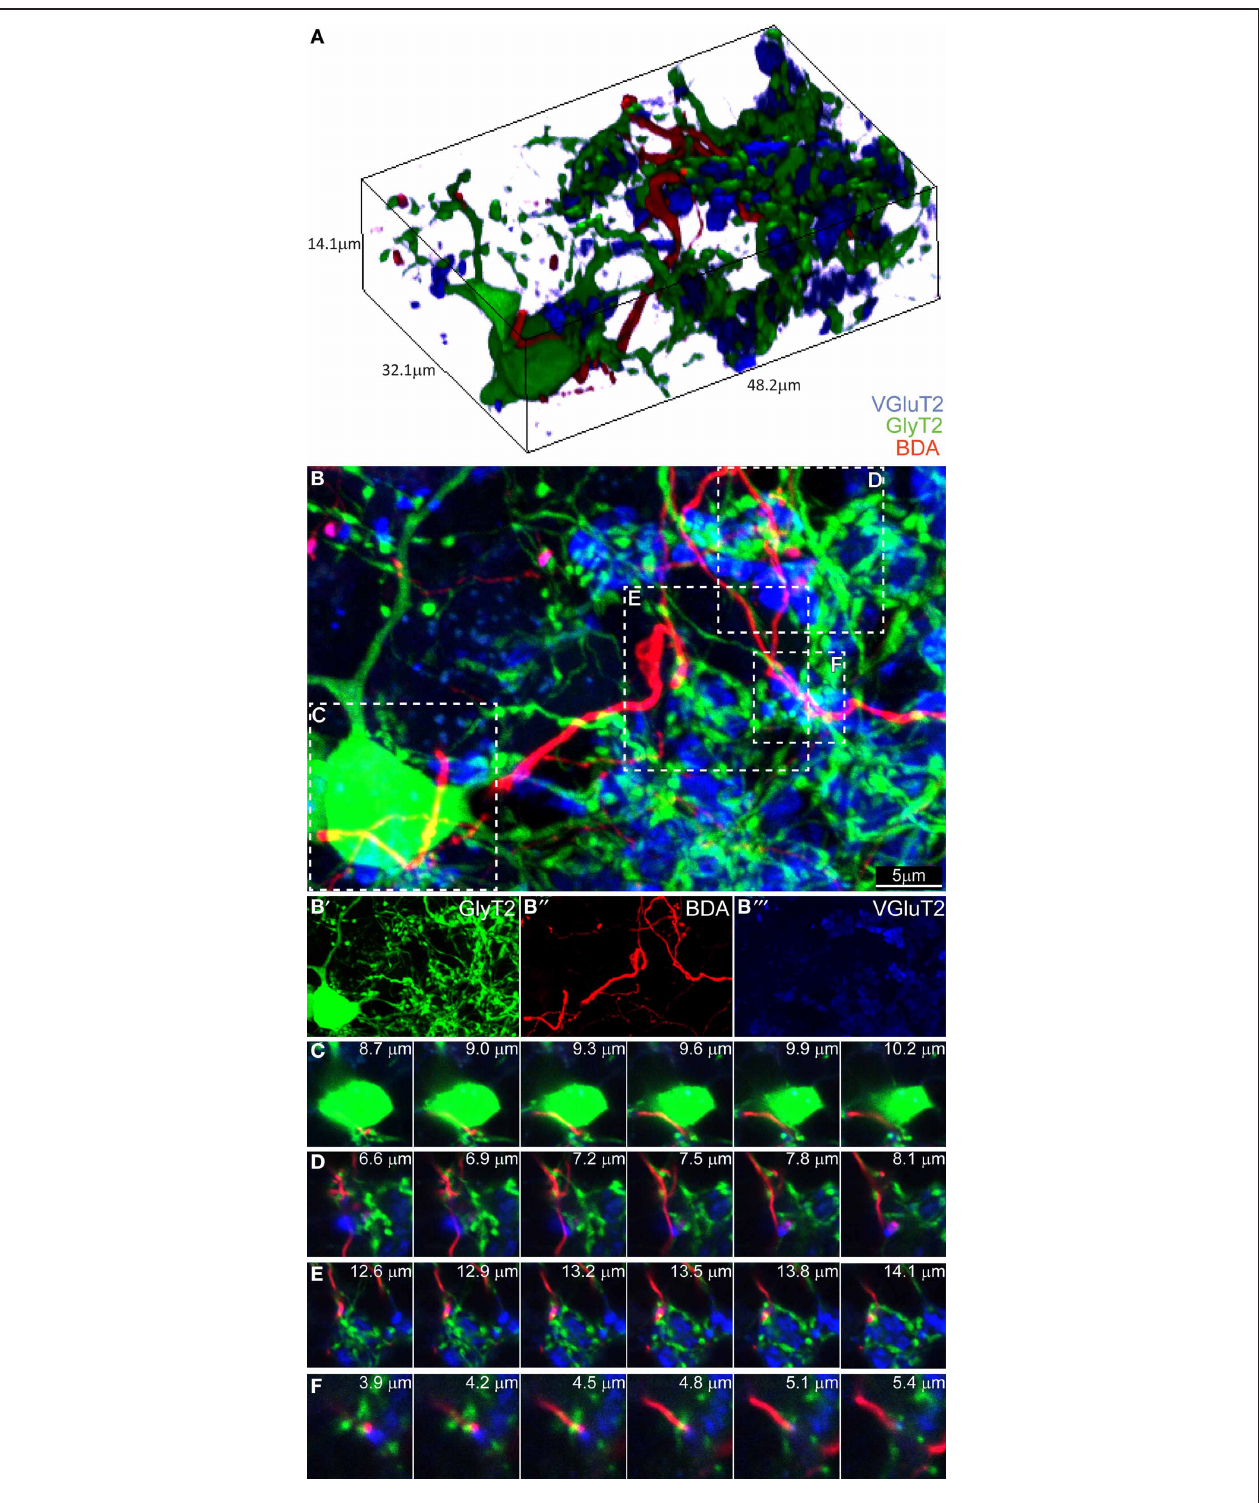
positive, in blue). (B) Maximum intensity projection of the 3D image (14.1 µ m thick), with below the three individual channels (B’–B”’) . Five possible triplets are indicated in the insets (C–F) . Montages of the five potential synapses analyzed in the z-plane. In all five instances the CF does not co-localize with VGlut2, arguing against the existence of synaptic